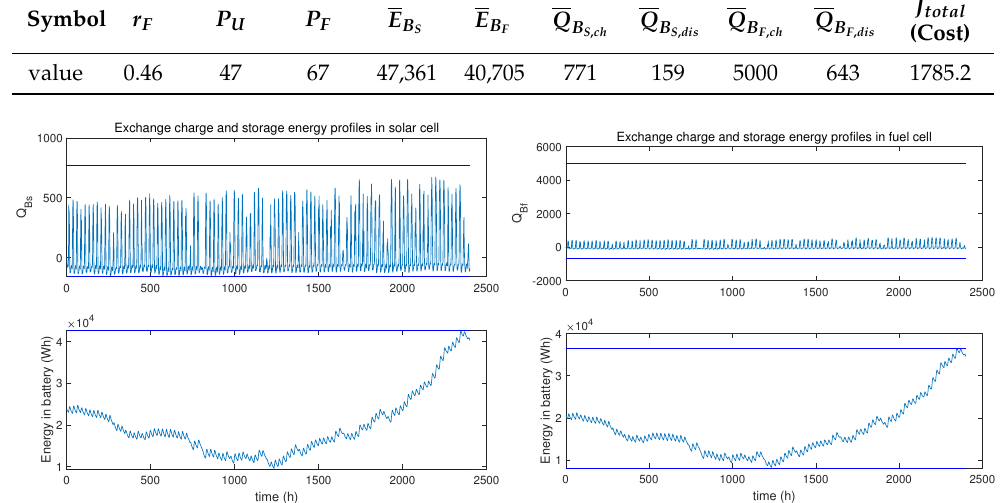
Figure 10. Profiles of exchange charge and storage energy profiles in a solar cell and a fuel cell.